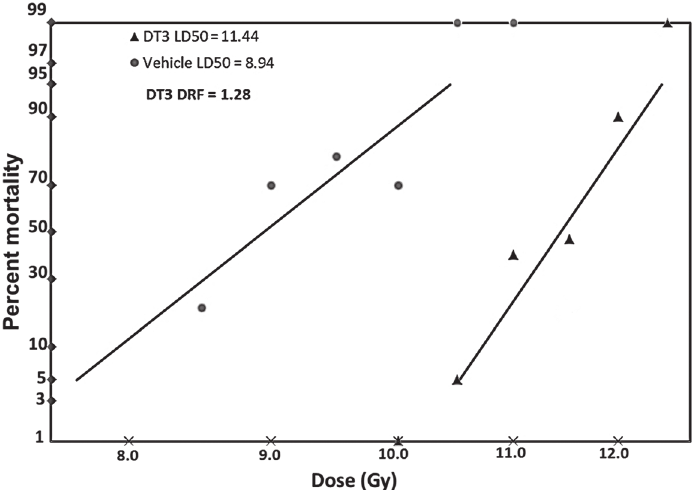
Fig 1. DT3 protected mice against lethal γ -irradiation. DT3 (75 mg/kg) or vehicle was administered as a single subcutaneous injection to mice 24 h before total-body gamma-radiation (TBI) at a dose rate of 0.6 Gy/ min. Thirty-day survival was monitored after different doses of gamma-radiation. Survival data were used to evaluate the DT3 dose reduction factor (DRF, N = 20 mice/group). The DRF of DT3 was determined to be 1.28 (p <